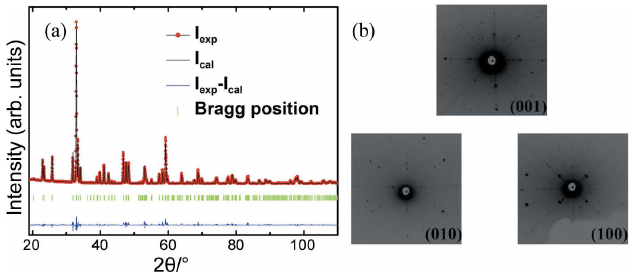
Figure 1 ( a ) X-ray diffraction pattern and ( b ) Laue back-scattering photography of SmFe 0.75 Mn 0.25 O 3 single crystal along the (001), (010) and (100) crystallographic